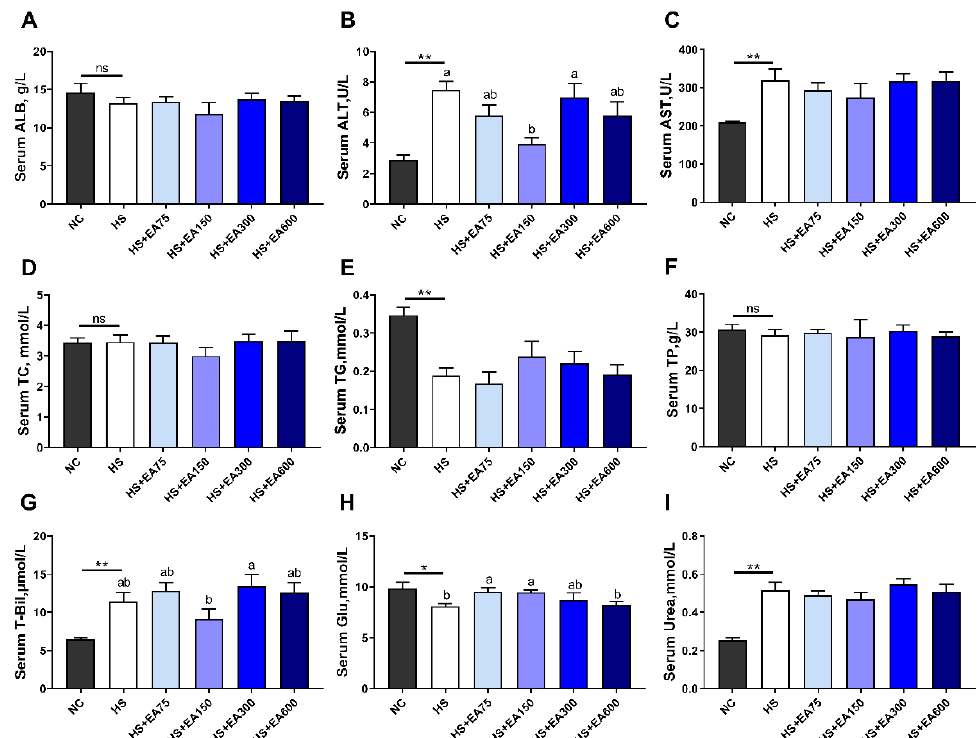
Figure 4. Effects of different levels of dietary EA on serum biochemical parameters of heat-stressed broilers. ( A ) Serum ALB, albumin. ( B ) Serum ALT, glutamic-pyruvic transaminase. ( C ) Serum AST, aspartate transaminase. ( D ) Serum TC, total cholesterol. ( E ) Serum TG, triglyceride. ( F ) Serum TP, total protein. ( G ) Serum T-Bil, total bilirubin. ( H ) Serum Glu, glucose. ( I ) Serum urea. Data are presented as mean ± SEM (n = 6). NC (negative control) represents the broilers supplemented with a basal diet at normal temperature (23 ± 2 ◦ C). The broilers in the 5 experimental groups were supplemented with basal diets containing different levels of EA (0, 75, 150, 300, and 600 mg/kg) at HS temperature (35 ± 2 ◦ C), which are represented as HS, HS + EA75, HS + EA150, HS + EA300, and HS + EA600, respectively. Shared superscript letters indicate no significant difference ( p > 0.05). “*” indicates a significant difference between groups where p < 0.05. “**” indicates a significant difference between groups where p < 0.01. “ns” indicates a no significant difference between groups where p > 0.05.